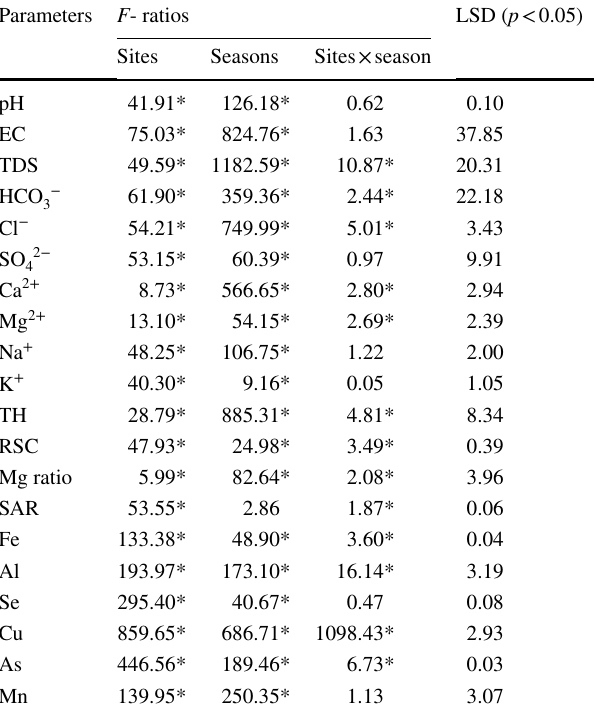
Table 4 Two-way ANOVA for water quality parameters of samples collected in the proximity of tributaries of Beas River, India